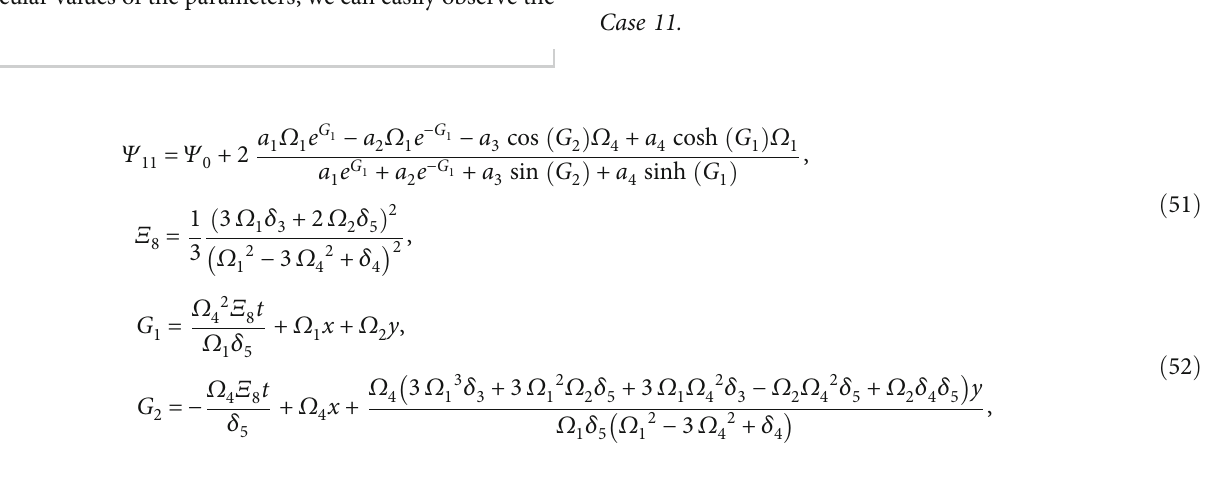
Figure 7: Plot evolution of periodic waves (28) utilizing values a = 1 : 3, δ = 2, Ψ = 1, t = 10 and (a) 3D plot, (b) density plot, and (c) contour 5 0